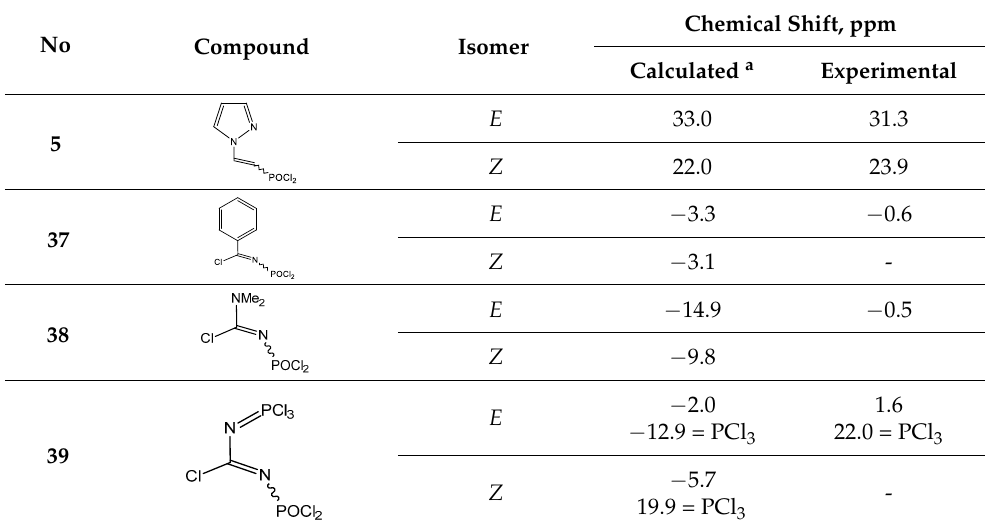
a Averaged by conformational states. The calculated 31 P chemical shift of complex 32 in the gas phase ( − 63 ppm) differs significantly from the experimental value ( − 264.3 ppm) and corresponds to the range typical of five-coordinate phosphorus atoms, about − 80 ppm (Table 9). Based on calcula- tions for the gas phase by means of B3LYP/6-311G(d,p), the distance between pyridine nitrogen atoms and phosphorus atoms exceeds 4 Å, while the PCl 5 molecule retains the bipyramidal configuration. Thus, the formation of a molecular complex between 1-allyl-3,5-dimethylpyrazole and phosphorus pentachloride does not occur in the gas phase. Taking into account the influence of the solvent (nitromethane), the P–N distance shortens to 2 Å, and (as in complex 28 ) the steric configuration of the PCl 5 molecule transforms from trigonal bipyramidal to octahedral. This is accompanied by an increase in the calculated 31 P NMR chemical shift (up to − 282.5 ppm) in the energetically most favorable s- trans conformer. Assessment of the 31 P chemical shifts of the starting phosphorus pentachloride and its molecular complexes with azoles shows that the creation of the N → P dative bond is attended by a low-frequency shift of the phosphorus signal by 220 ppm, of which 60 ppm is due to the contribution of the spin–orbit interaction [56]. The effect of the solvent must be taken into consideration when optimizing the geometric parameters and calculating the 31 P NMR chemical shifts for intra- and inter- molecular complexes formed with the participation of a phosphorus atom and a nitrogen atom in heteroaromatic systems. As in the case of intramolecular coordination in the 15 Z isomer, allowance for the effect of the solvent is of decisive importance because the sol- vent is responsible for the stabilization of such complexes. Accounting for relativistic ef- fects is essential for the accuracy of predicting 31 P chemical shifts. The contribution of the spin–orbit interaction is about 200 ppm, and neglecting this contribution would lead to incorrect predictions. 6. Theoretical 31 P NMR Chemical Shifts of Pyrazolylphosphine and Related Com- pounds A similar theoretical approach was applied to the study of 31 P NMR chemical shifts and the stereochemical behavior of phosphonic acid dichlorides containing the POCl 2 group at the C=C and C=N double bonds, i.e., 2-(pyrazolyl)ethenylphosphonic acid di- chloride ( 5 ) and the related compounds, N -dichlorophosphonylimin obenzoic acid chlo- ride ( 37 ), N ′ -dichlorophosphoryl- N , N -dimethylchloroformamidine ( 38 ). These were prepared by the phosphorylation of N , N -dimethylurea with phosphorus pentachloride [57] and 1-trichlorophosphazo-1-chloro-2-dichlorophosphoryl-2-azaethene ( 39 ) obtained by the interaction of urea with phosphorus pentachloride [58]. The 31 Р NMR chemical shifts were also calculated by the GIAO-B3LYP-ZORA/DZP for the predominant con- formation of compounds 5, 37 – 39 for the gas phase (Table 10) [59]. The theoretical 31 Р NMR chemical shift values are also recalculated by the Equation (2). Analysis of the NMR spectra shows that compound 5 existed in the form of two isomers which were assigned by the measurement of spin–spin coupling constants 3 J РН